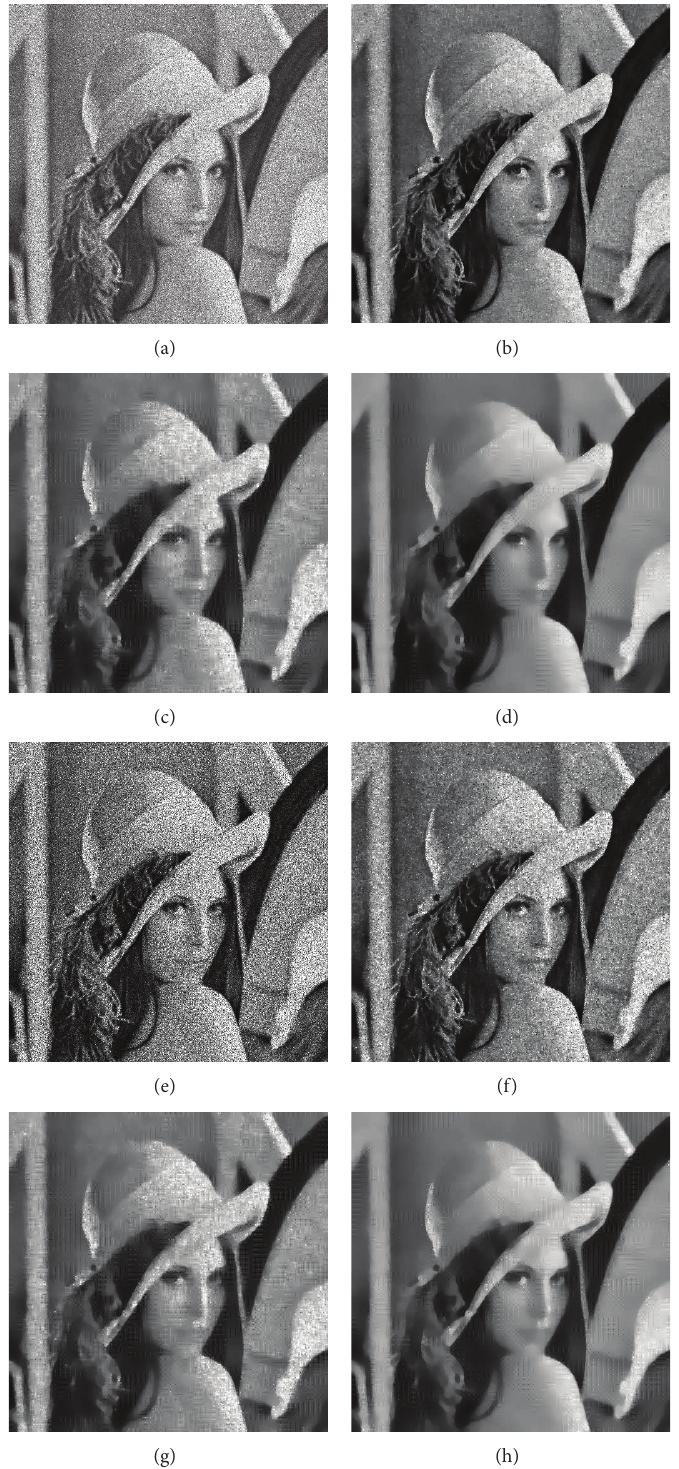
Figure 2: Images restored using various methods, images of “Lena”: (a) and (e): noisy images with mean 1, noise variances 0.1 and 0.2, and Gaussian blurs with kernel spread of 3 & 4, respectively; (b) and (f) restored using RLO method [10]; (c) and (g) restored using AA filter [8]; (d) and (h) restored using the proposed